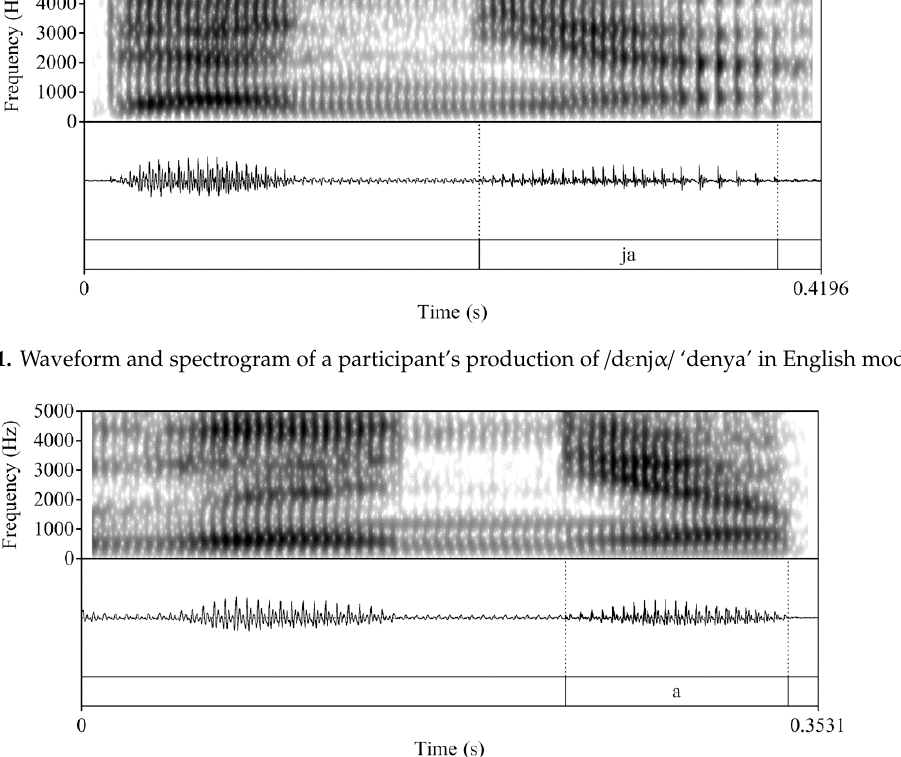
Figure 2. Waveform and spectrogram of a participant’s production of /d eɲa/ ‘deña’ in Spanish mode.